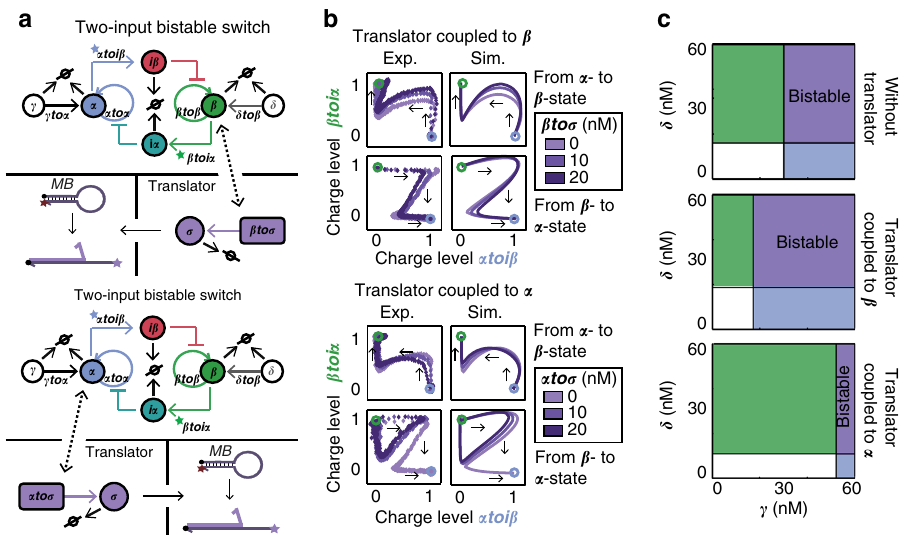
Fig. 4 Characterizing retroactivity from coupling of the translator module to the memories circuit. a Schematic illustration of the system, in which the translator module is coupled to α or β of the PEN-based bistable switch. The core of the bistable switch consists of four templates, including the autocatalytic templates α to α and β to β and the inhibitory templates α toi β and β toi α . The network switches between states upon injection of γ and δ which are received by templates γ to α and δ to β . The dynamics of the bistable switch are followed via N-quenching using templates β toi α and α toi β which are 3 ′ -end labeled with a DY530 and FAM fl uorophore, respectively. b Experimental (Exp.) and simulated (Sim.) phase diagrams for a concentration range of translator template coupled to α or β . Experiments were carried out as described in the Methods using 20 nM β toi α , 15 nM α toi β , 24 nM β to β , 10 nM α to α , γ to α , and δ to β , 15 U mL − 1 Bst 2.0 WarmStart DNA polymerase, 10 U mL − 1 Nt. bstNBI, and 200 nM ttRecJ. The switch was either equilibrated to its α -state and 30 nM δ was injected for switching to the β -state or the switch was equilibrated to its β -state and 30 nM γ was injected for switching to the α -state. The charge level is the normalized fl uorescence of the signal of DY530 and FAM fl uorophores, which is 0 in the absence of template ’ s input primer and 1 at the steady-state value of primer β and α , respectively. The blue and green circles represent the α -state and β -state, respectively. Simulations were performed using the heuristic model (Supplementary Notes) and the traces were converted to normalized units (n.u.) by normalizing α and β to their steady-state concentrations. c Bifurcation diagrams of the switch in isolation and with 10 nM of translator module coupled to β or α as a function of inputs γ and δ obtained using the heuristic model (Supplementary Notes). The monostable domains of α and β are shown in blue and green, respectively, while the bistable domain is shown in